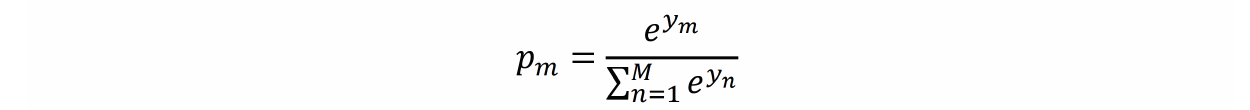
Figure 5. Class probability calculation; where pm represents the probability for class m, ym is the ensemble prediction score for class m, and M is the number of